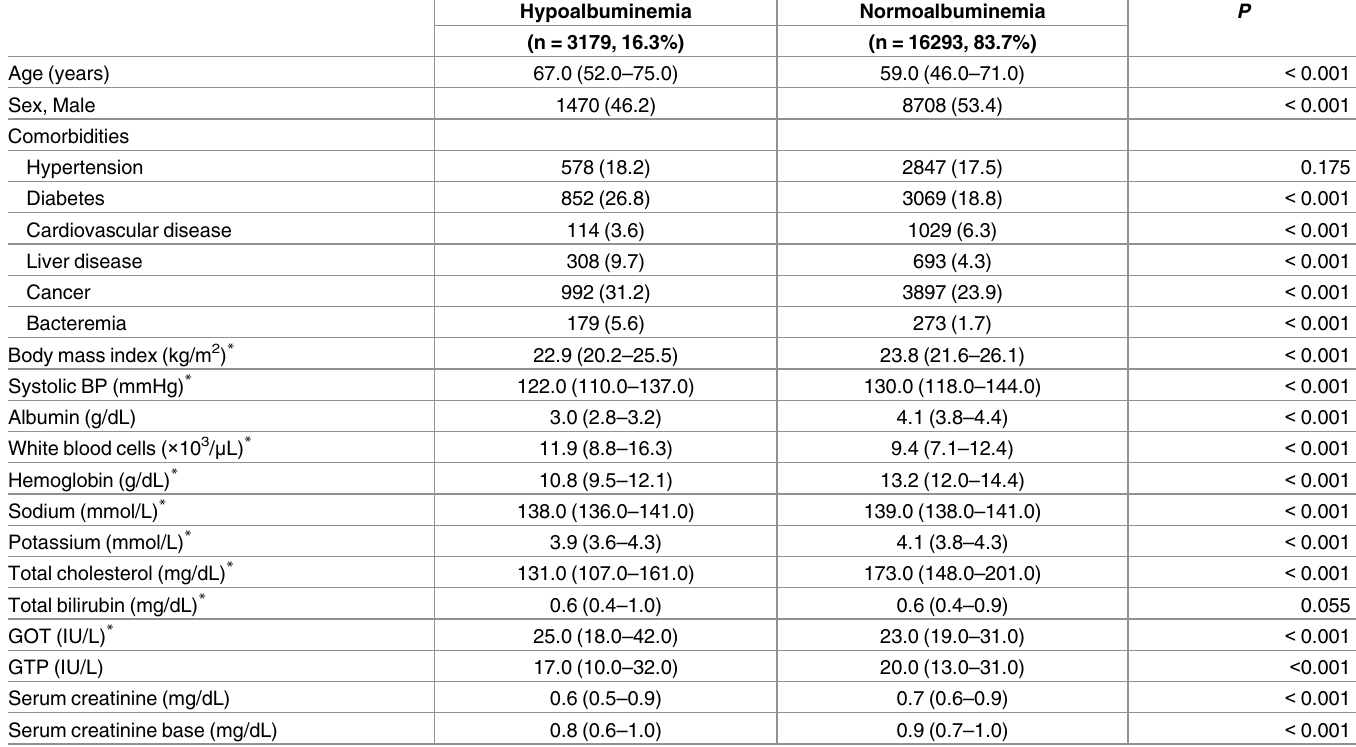
Table 1. Baseline characteristics of the study